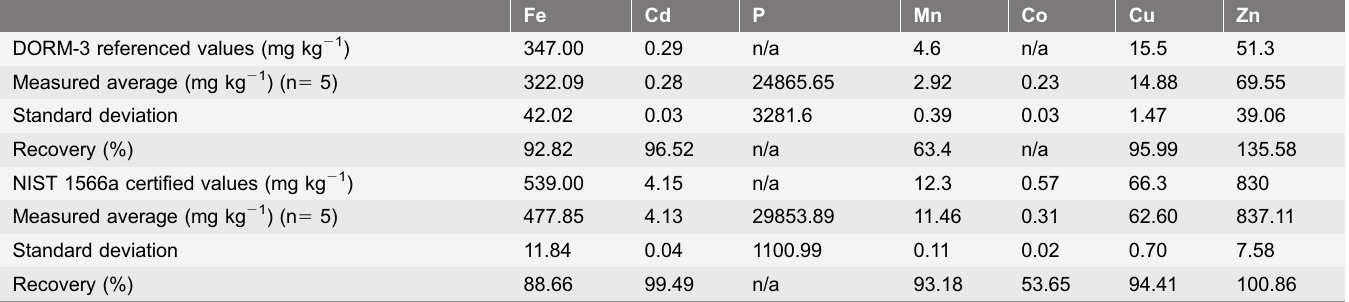
Table 1. Elemental analysis using sector field inductively coupled plasma mass spectrometry (SF-ICP-MS) for certified referenced material of fish protein (Certified Reference Material number: DORM-3) and oyster tissue (National Institute of Standards and Technology (NIST), Certified Reference Material number 1566a).